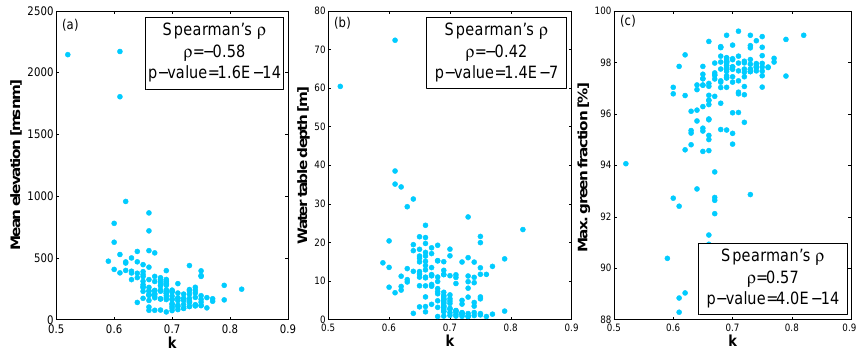
Figure 11. Parameter k vs. landscape